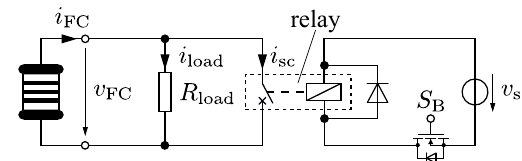
Figure 7. Setup of experiment for external short circuit tests.